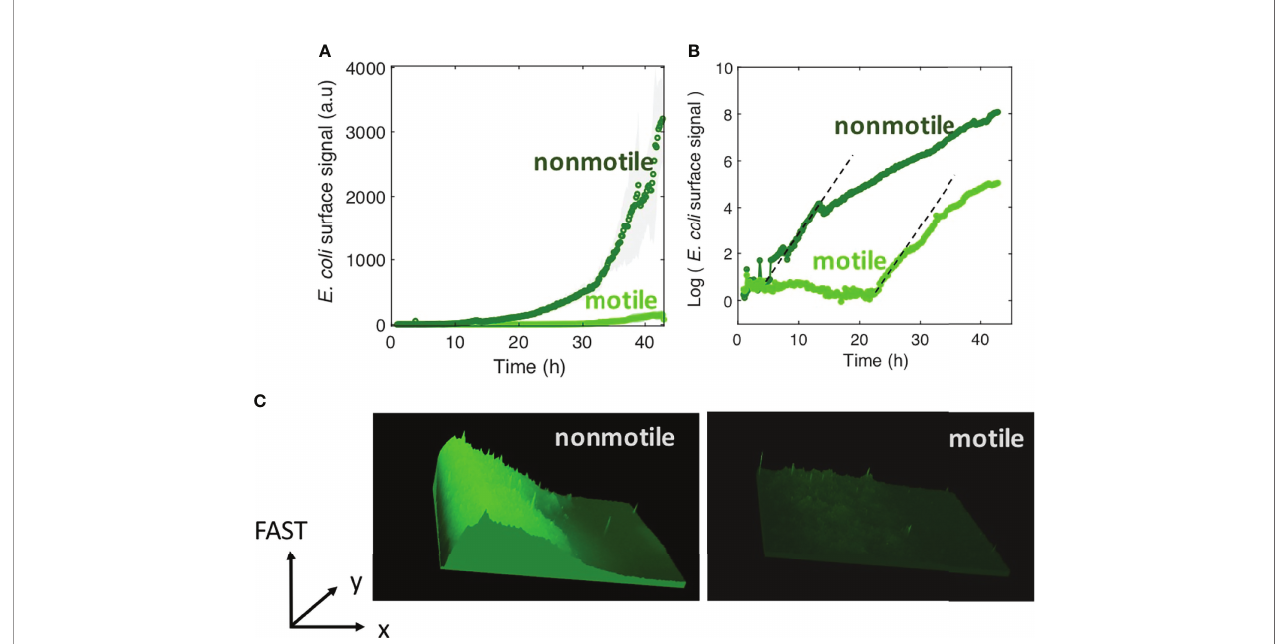
FIGURE 1 | Motility delays bio fi lm formation. (A) E. coli FAST fl uorescence intensity as a function of fl ow time for a bio fi lm grown by motile (bright green) and nonmotile (dark green) cells in a milli fl uidic channel; bold curves are from the average intensity of 3 distinct positions in 2 or 3 different channels with the shaded area representsing the standard deviation (B) Same data as in A except the logarithm of the average fl uorescent intensity is plotted. The bio fi lm was grown at a rate of 1 ml/h medium fl ow, at 30°C. Dashed lines highlight the exponential part of the growth and display the same slope for both motile and nonmotile cells. (C) Fluorescence intensity surface plots from bio fi lm images recorded at time t=30h. Bio fi lm from nonmotile cells on the left panel and from motile on the right